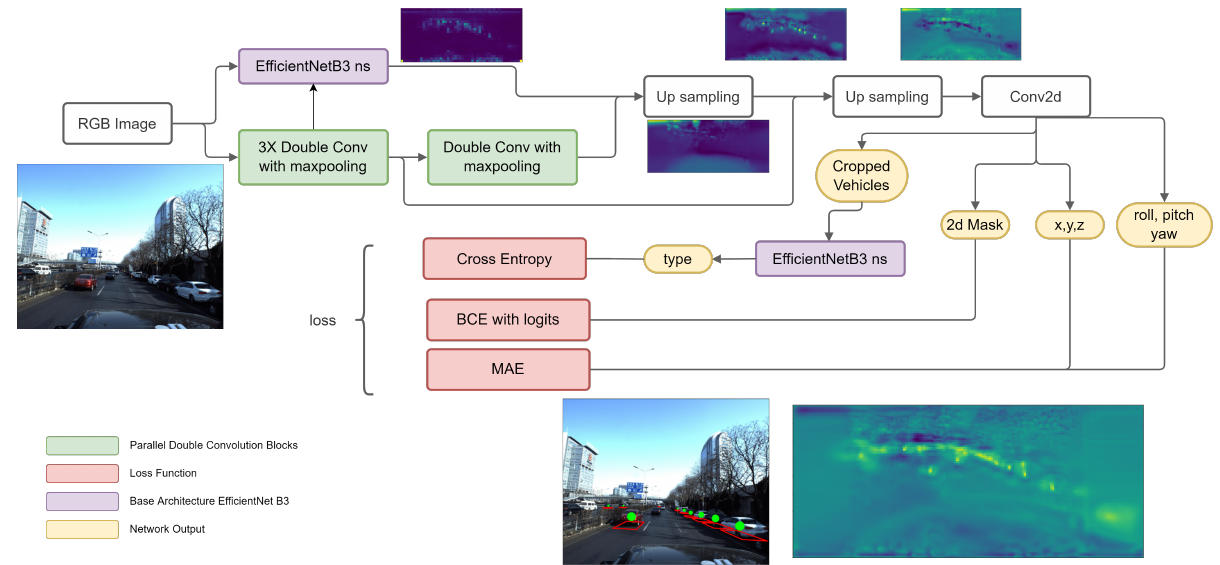
Figure 3. The proposed neural network model